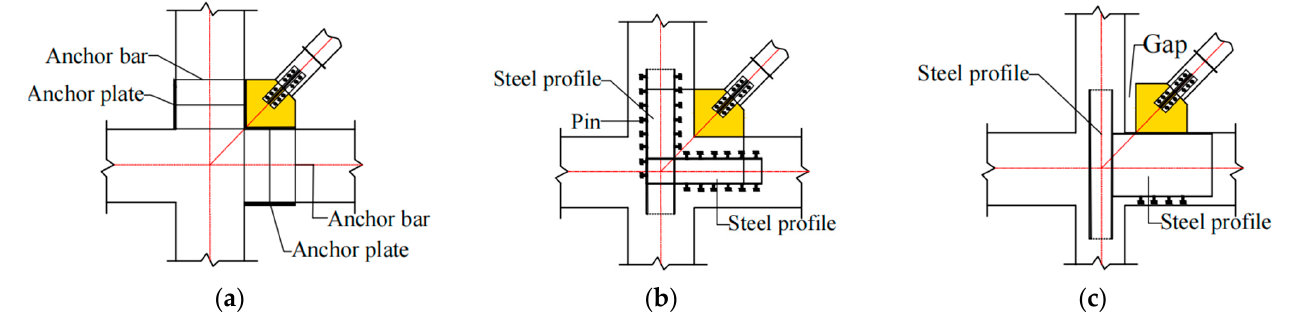
Figure 1. Traditional gusset connection configurations: ( a ) Anchorage connection; ( b ) Embedded steel plate connection; ( c ) Unconstrained connection.